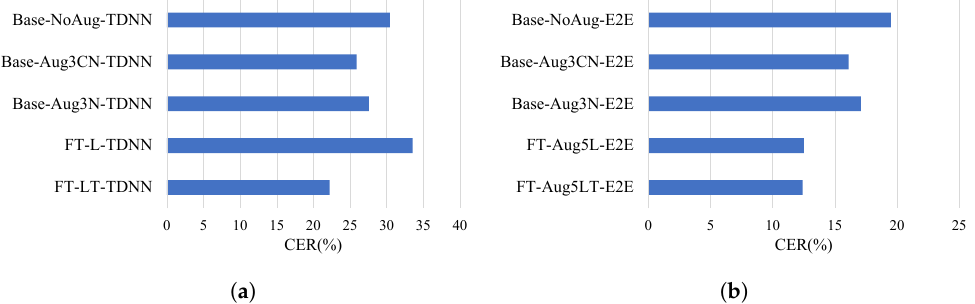
Figure 7. Performance of data augmentation on telephone channel speech. ( a ) TDNN: domain adaptation for LTE, ( b ) E2E: domain adaptation for LTE.